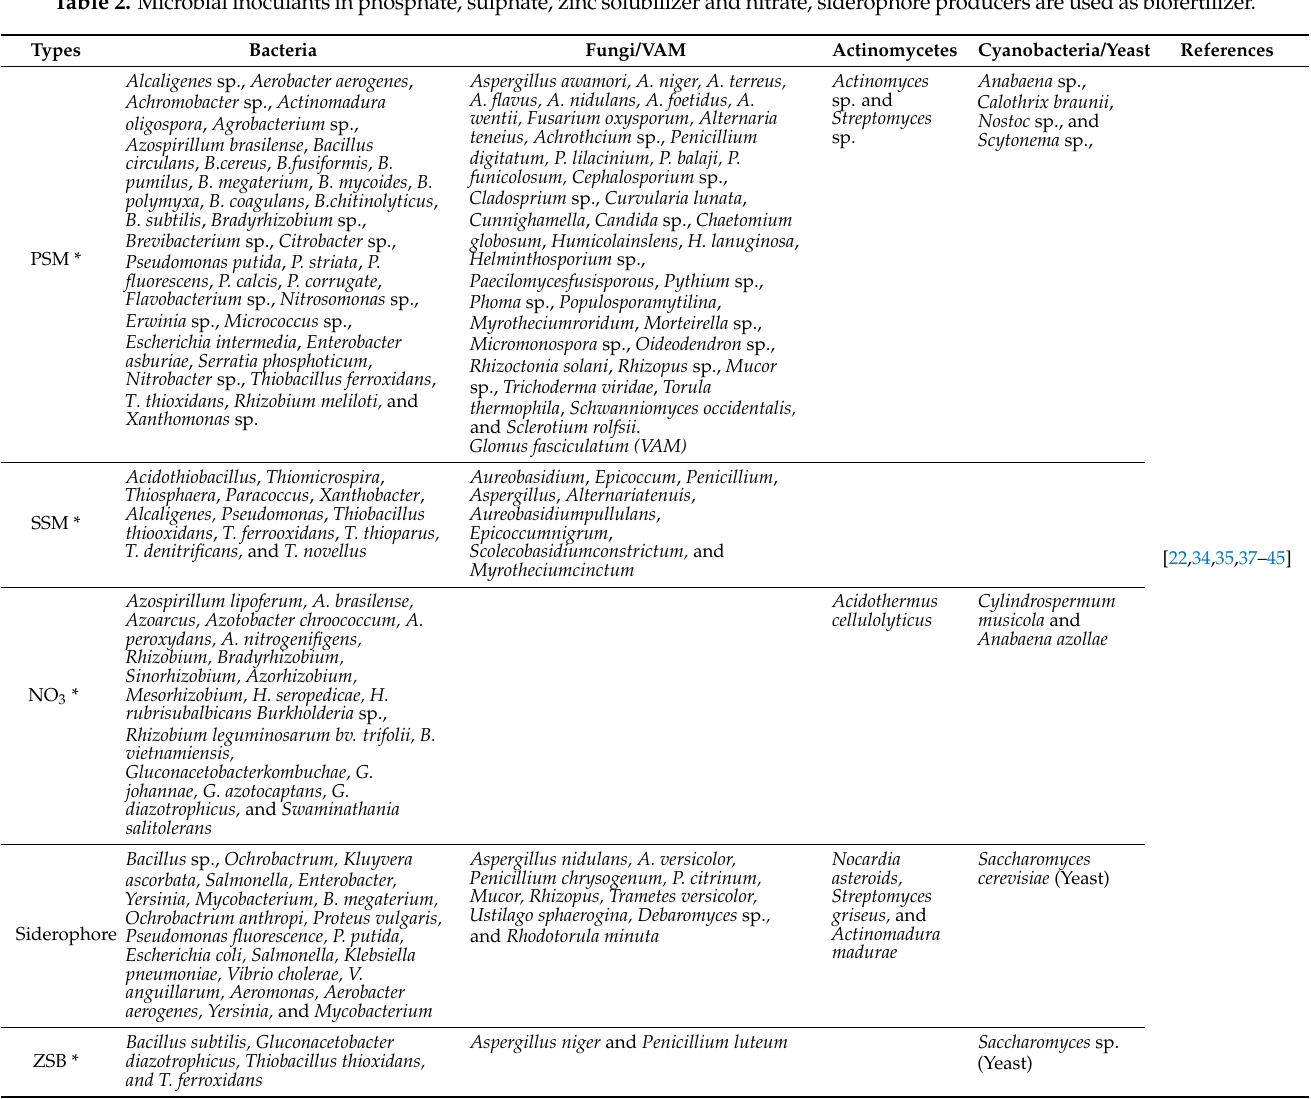
Table 2. Microbial inoculants in phosphate, sulphate, zinc solubilizer and nitrate, siderophore producers are used as